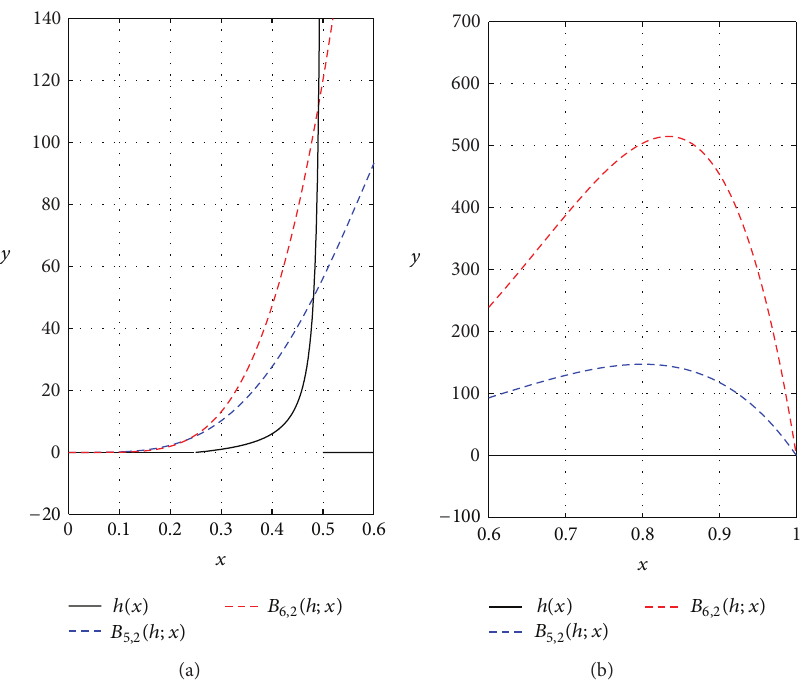
Figure 4: Graphs of 𝑦 = ℎ(𝑥) and 𝑦 = 𝐵 𝑛,2 (ℎ;𝑥) , 𝑛 = 5,6